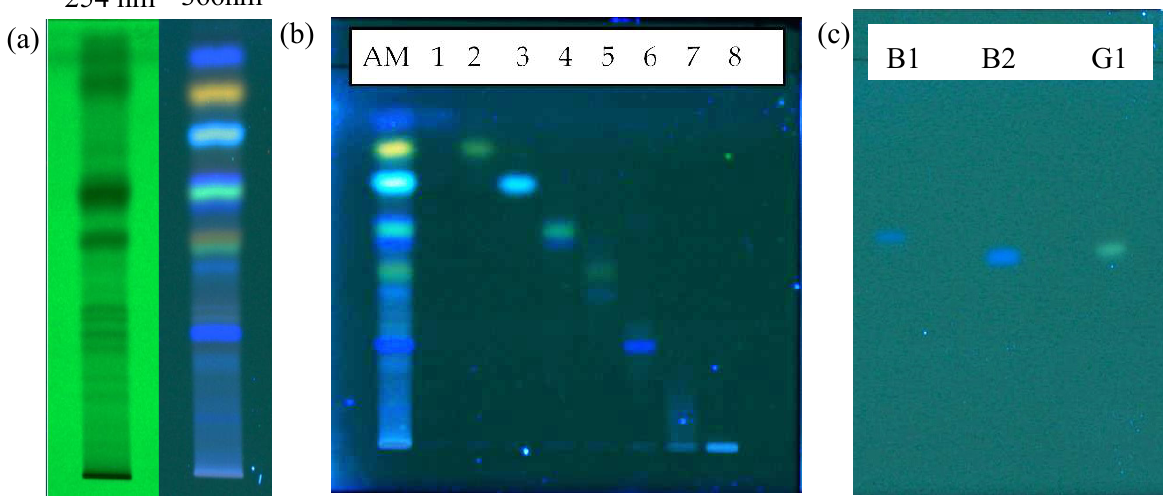
Figure 4. 5 α -R1 inhibitory activity assay of the eight AM fractions numbering 1–8 with 0, 19.2%, 13.3%, 50%, 18.9% 10.7%, 5.7% and 17.1% inhibition, respectively,